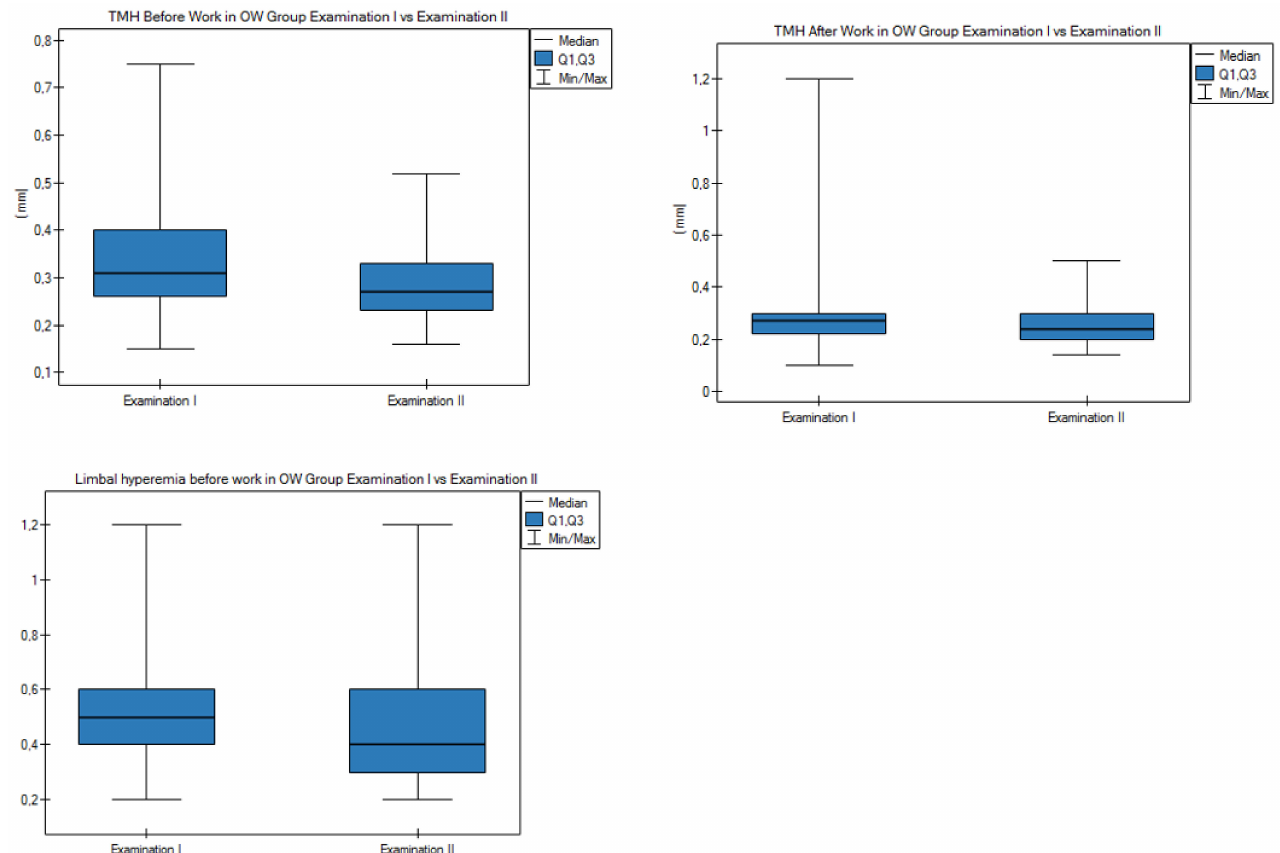
Figure 9. Measurement results of the eye surface parameters in the OW group and in the MW group at the 1-year follow-up. Table S5 is available in the Supplementary